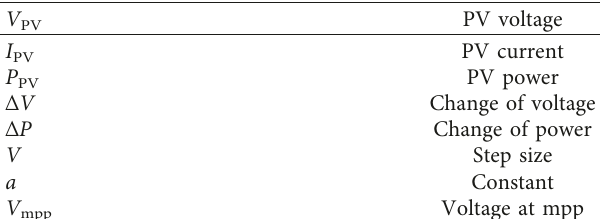
Figure 6: Proposed 100kW PV system connected to Mutobo hydropower: (a) block diagram and (b) Simulink model. Table 4: Parameter used for modified perturb and